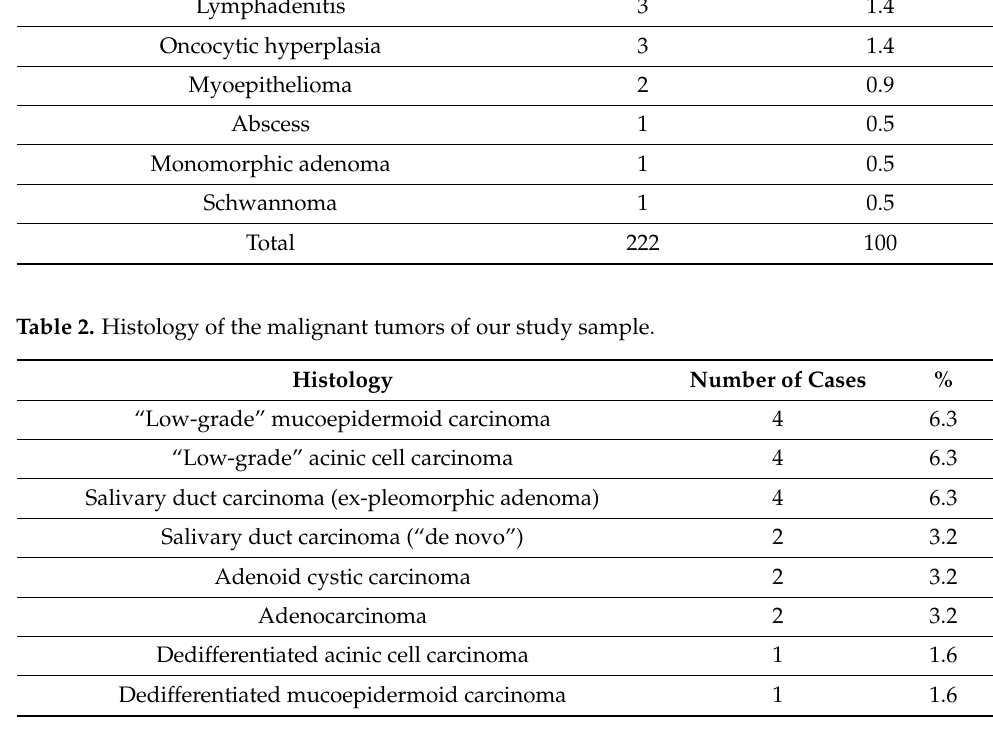
Table 5. Comparative analysis of the cases with displacement of the nerve and without any